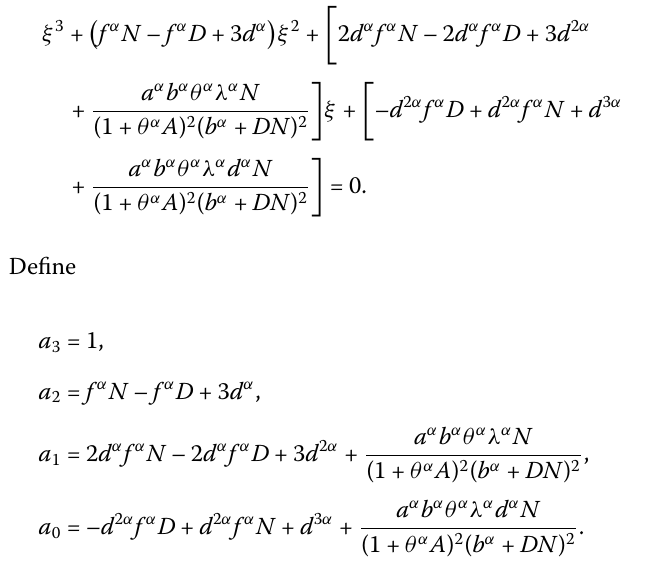
for ∀ i are j = 1, c ( q ) = (1 – 1+ q ) c ( q ) 0 j j –1 j